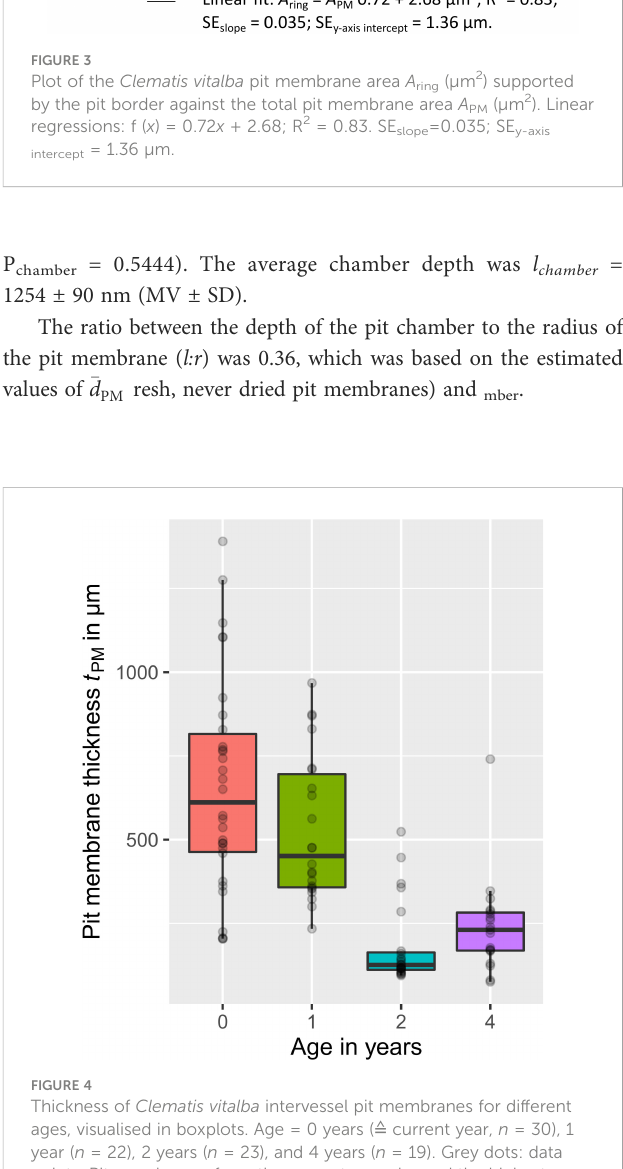
FIGURE 4 Thickness of Clematis vitalba intervessel pit membranes for different ages, visualised in boxplots. Age = 0 years ( ≙ current year, n = 30), 1 year ( n = 22), 2 years ( n = 23), and 4 years ( n = 19). Grey dots: data points. Pit membranes from the current year showed the highest thickness. Membranes that experienced one winter season were thinner. With further winters, the decreasing trend becomes more pronounced, even if in the fourth year the thickness is again slightly higher than the third